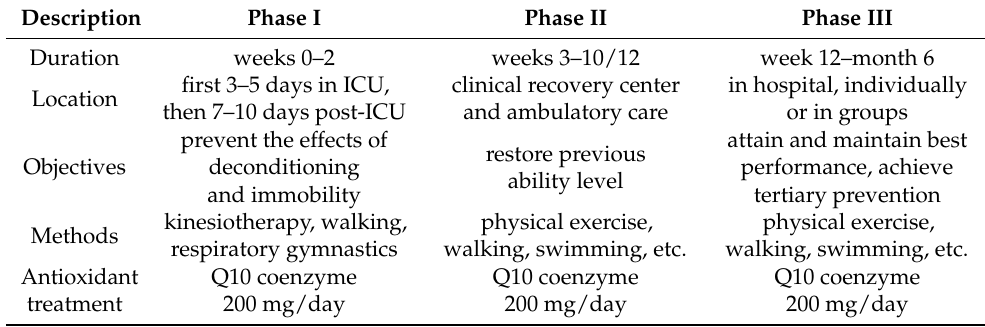
Table 1. Phases of the cardiac rehabilitation program and additional antioxidant